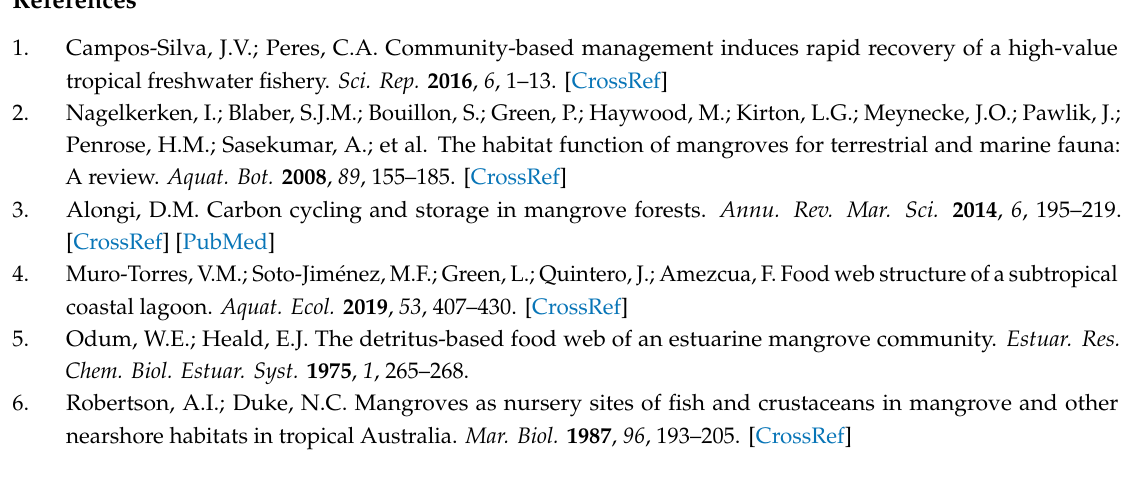
Table S1: Feeding strategy, food items, isotopic composition of δ 13 C and δ 15 N values (% (cid:24) , mean ± SD), and trophic position (TP) of the composite samples of seston, detritus, primary producers and main consumer species, and fish collected at the wetland of Teacap á n. N = number of samples. A% = relative abundance. B% = relative biomass. The organisms marked with “*” were used for the construction of the trophic